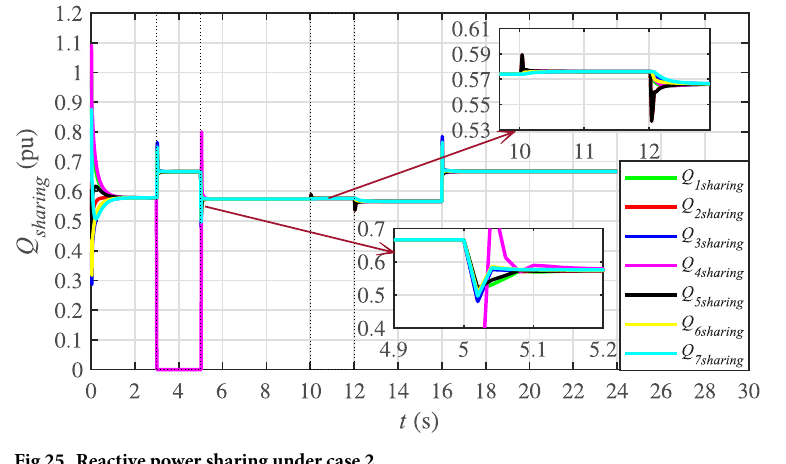
Fig 25. Reactive power sharing under case 2.